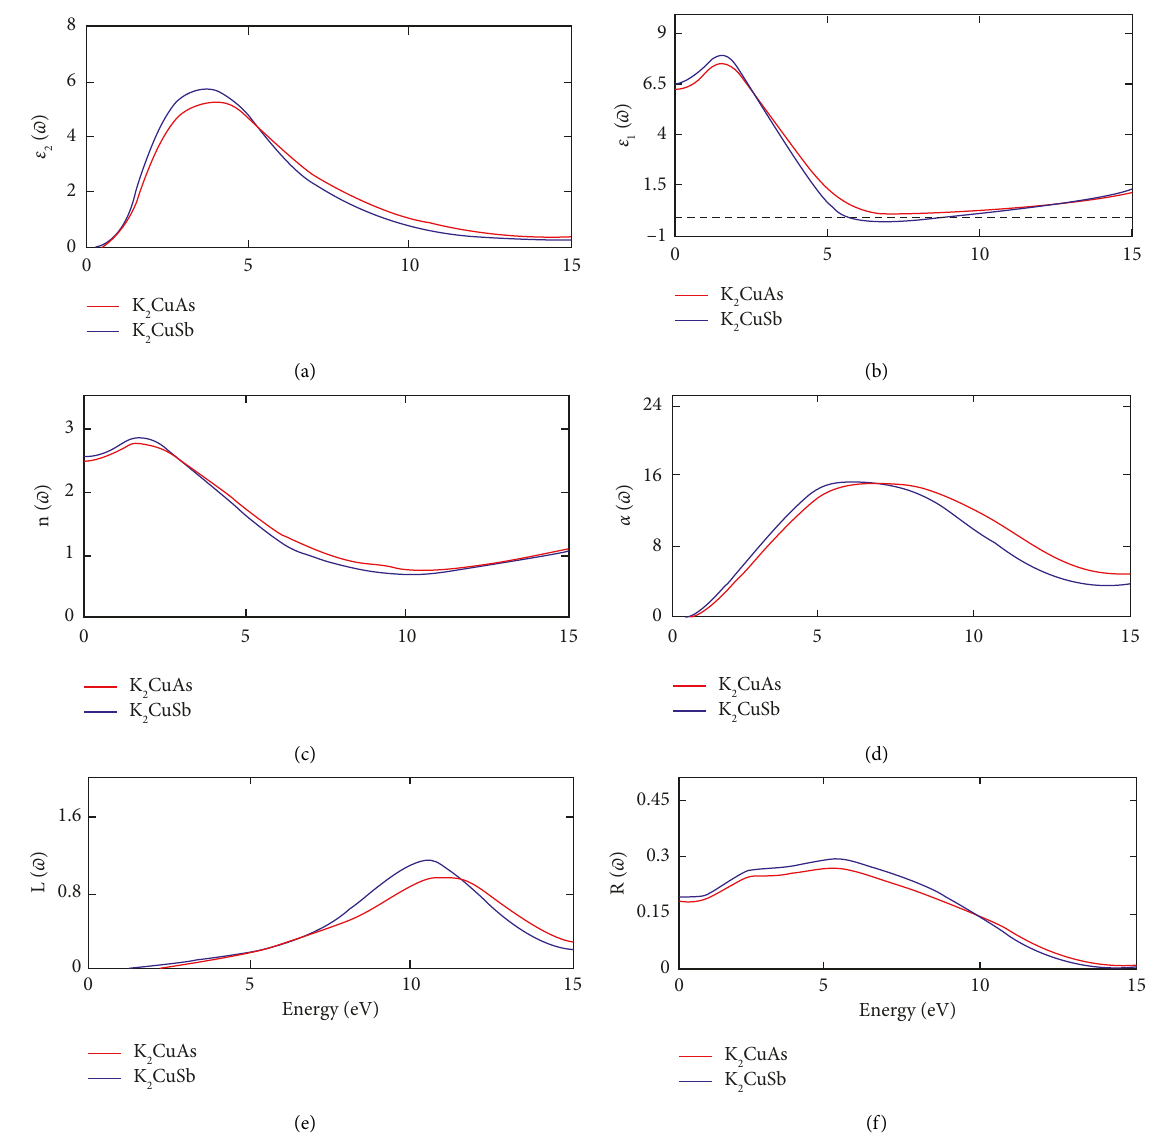
Figure 5: Calculated optical properties of K